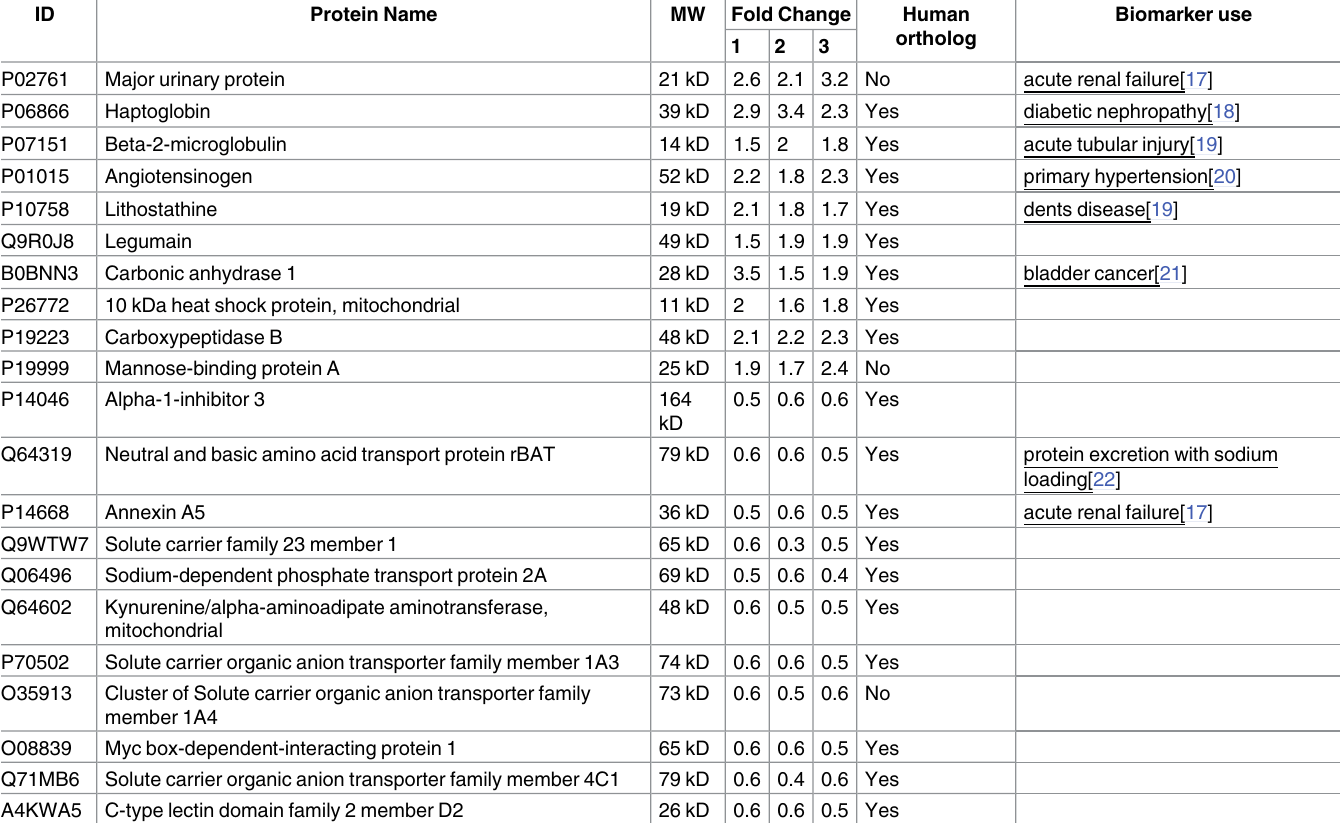
Table 1. Details of changed urinary proteins identified in the TMT